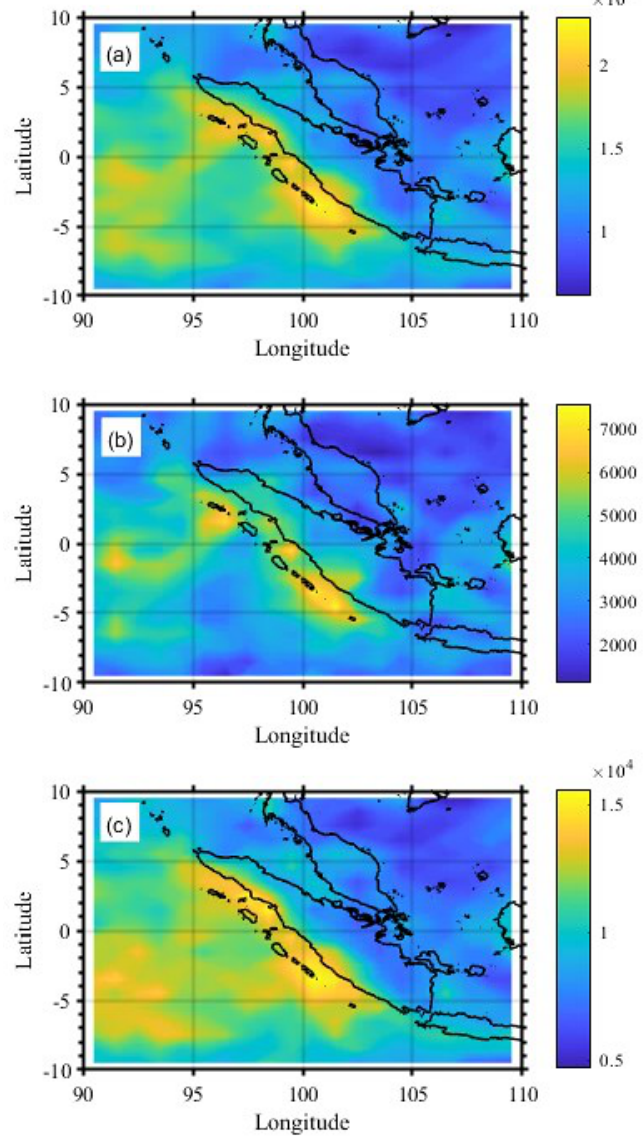
Figure 1. Spatial distribution of GPM level 2 data for a) all rainfall types, b) stratiform rain, and c) convective